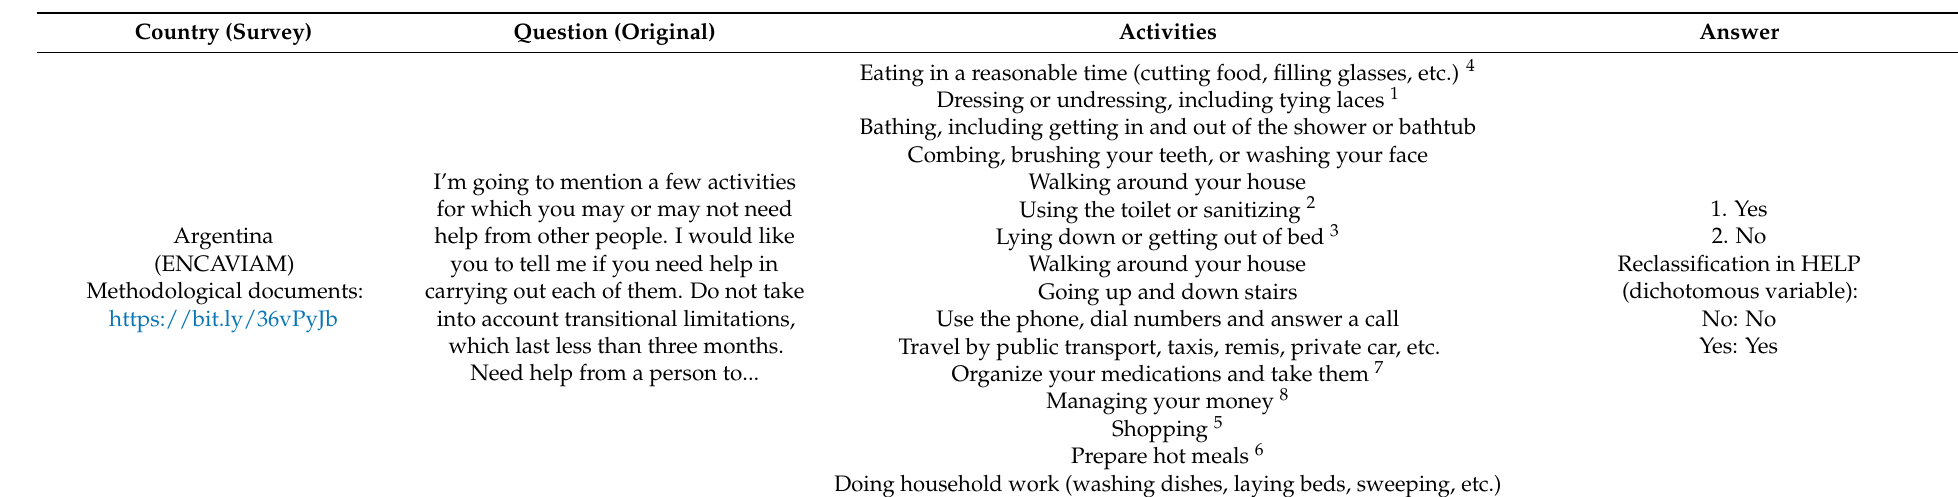
Table A2. BADL, IADL and need of help. Original questions by survey (in